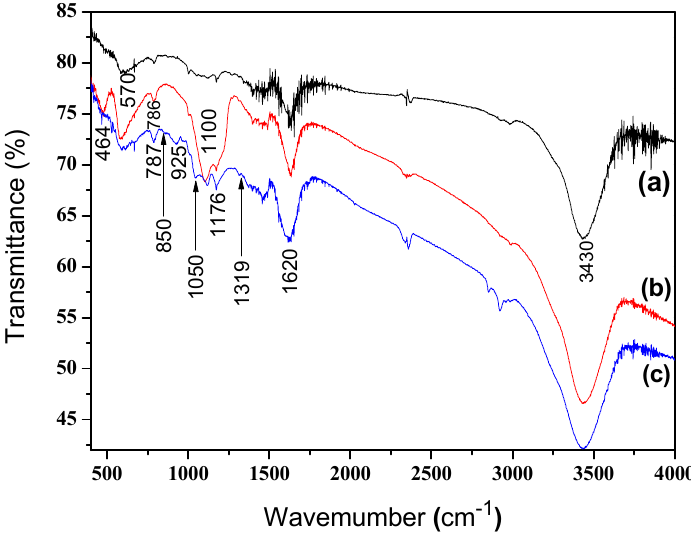
Figure 3. FT-IR spectra of (a) Fe 3 O 4 nanoparticles, (b) Fe 3 O 4 /SiO 2 core-shell composite nanospheres, and (c) Fe 3 O 4 /SiO 2 /PPy core-shell composite nanospheres.